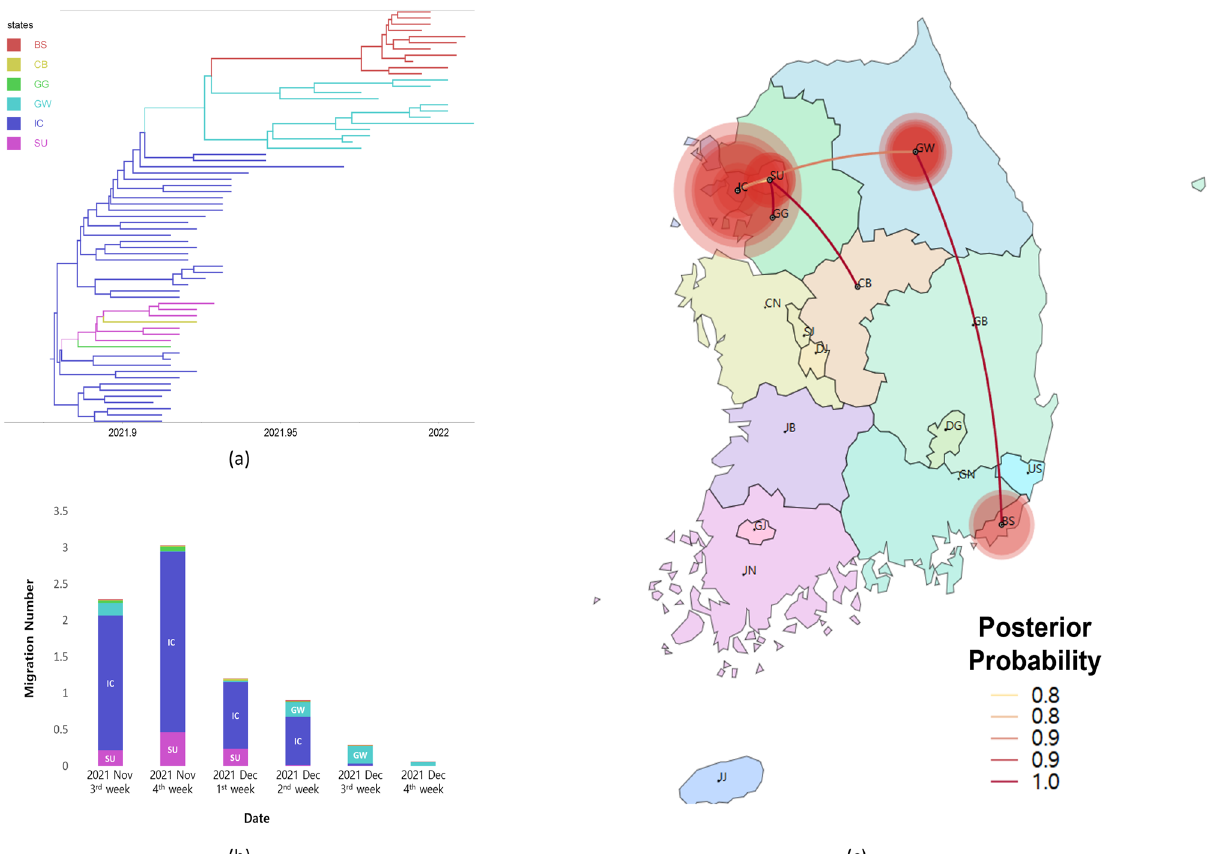
Figure 3. Phylogeographic result of the Kor-O2 subgroup. ( a ) Time-scaled maximum clade credibility tree of the Kor-O2 subgroup. Branches are colored according to their location in South Korea, and the branch thickness indicates the posterior probabilities of the inferred ancestral location. The phylogenetic tree with the virus name is available in Fig. S3. ( b ) Mean number of migration events of the Kor-O2 subgroup from major sources in Korea through time, which was estimated and computed by Bayesian phylogeographic analysis. ( c ) Transmissions of the Kor-O2 subgroup in South Korea visualized by SpreaD3. The color of the lines indicates the posterior probability. The diameters of the circles represent the number of branches maintaining a particular location state in each period. The video of the Kor-O2 transmission history is available on video S2 ( BS